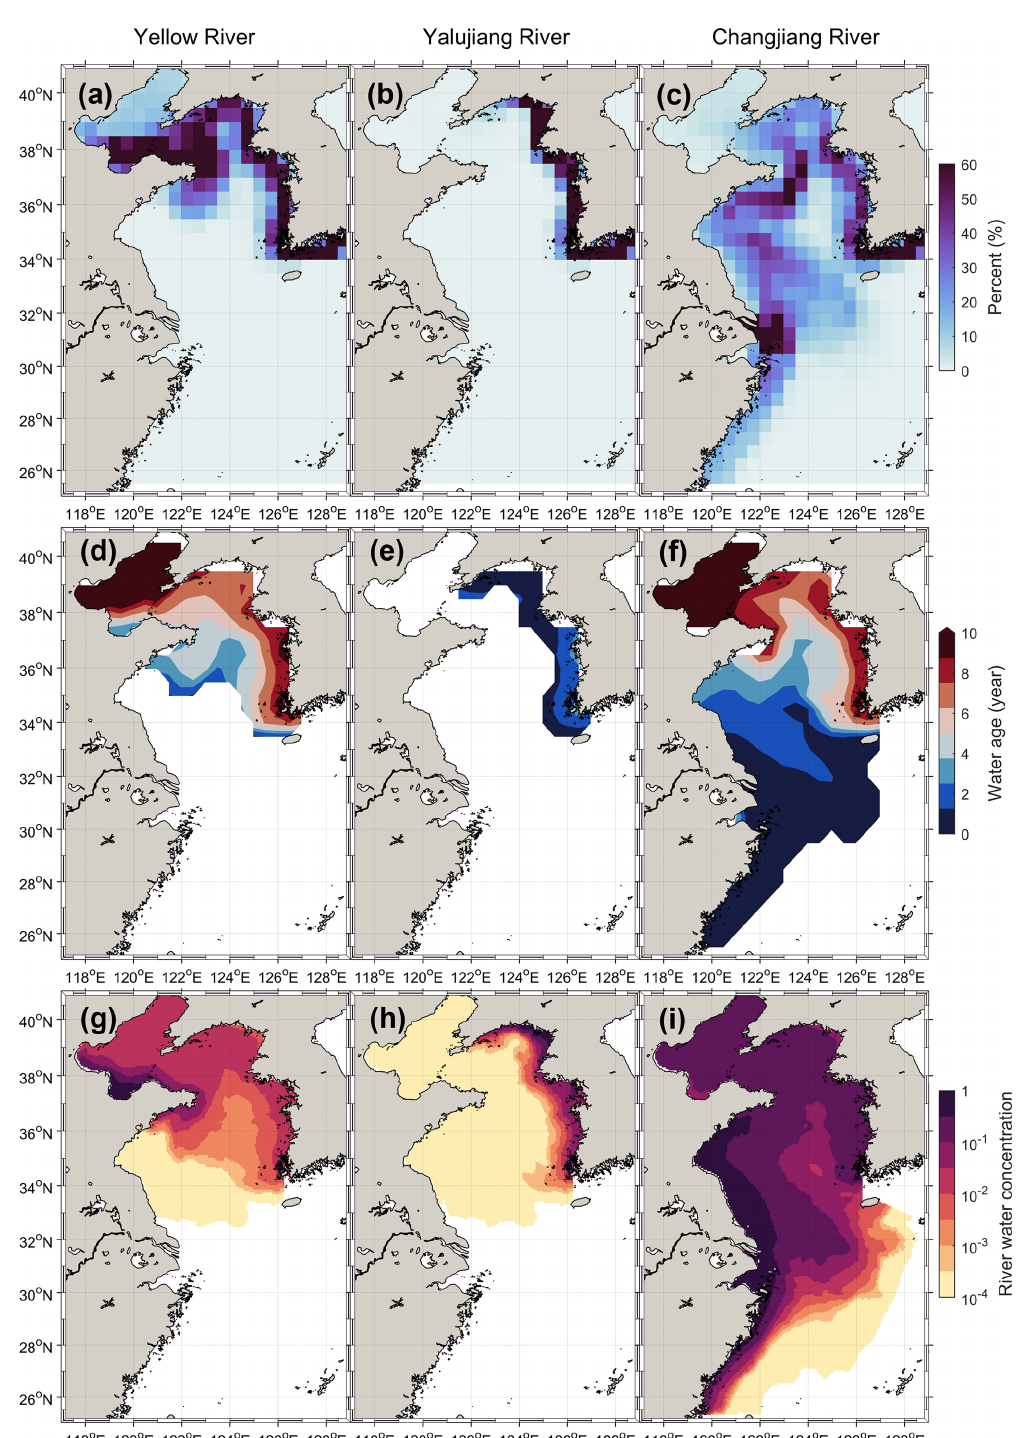
Figure 12. The three rivers’ waters transport pathways, age, and concentration for the PMT–tide case. The annually averaged emerging probability of particles (a–c) . The annually and vertically averaged water age (d–f) . The annually and vertically averaged river water con- centration (g–i)